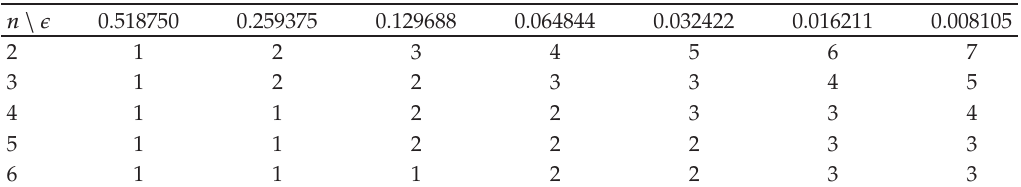
Table 2: Subdivision depth of tensor product n -ary interpolating volumetric models: here n presents the arity of subdivision volumetric model and (cid:5) presents error